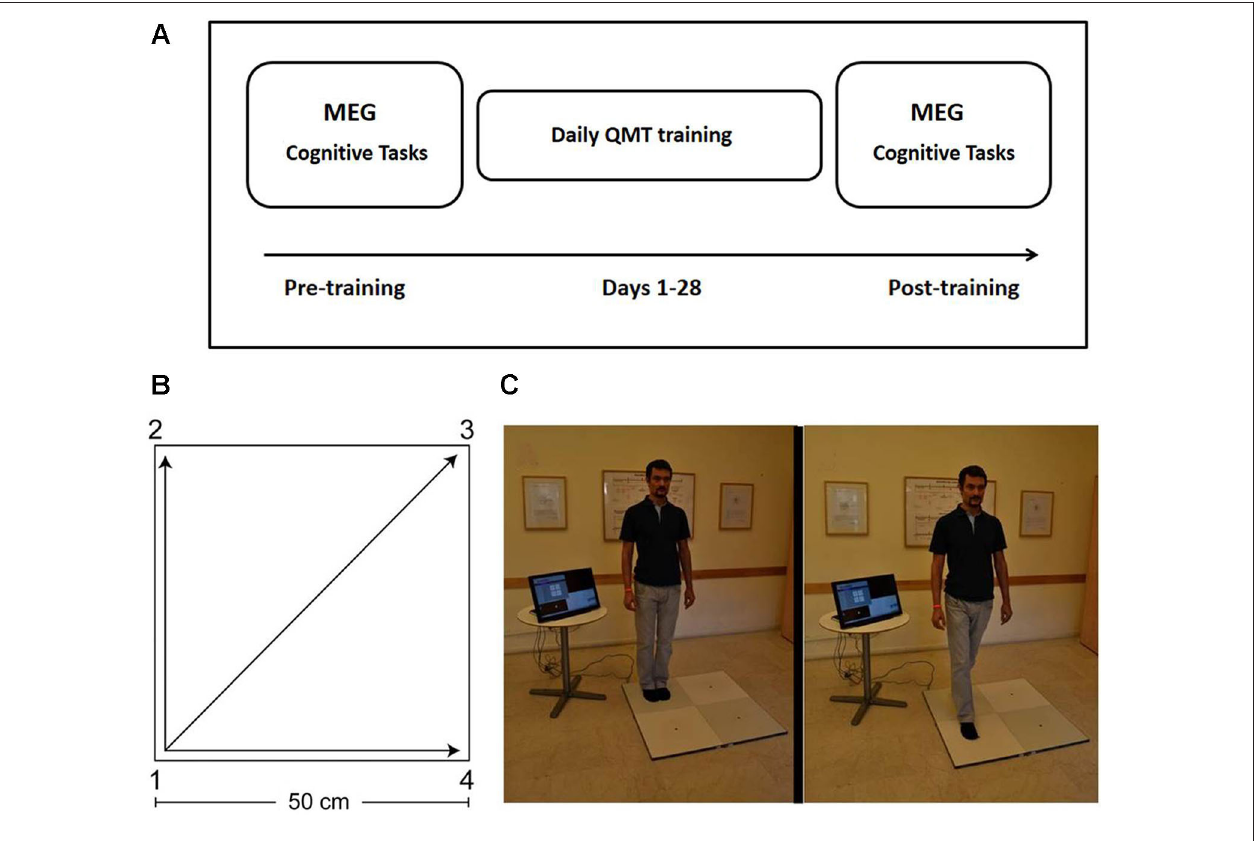
counterbalanced order. (B) The spatial layout of the training space. (C) Practice setup. The trainee listens to recorded instructions and takes a step towards the target point. Figure adapted from Ben-Soussan et al. (2014). Quadrato Motor Training = QMT; Magnetoencephalography =